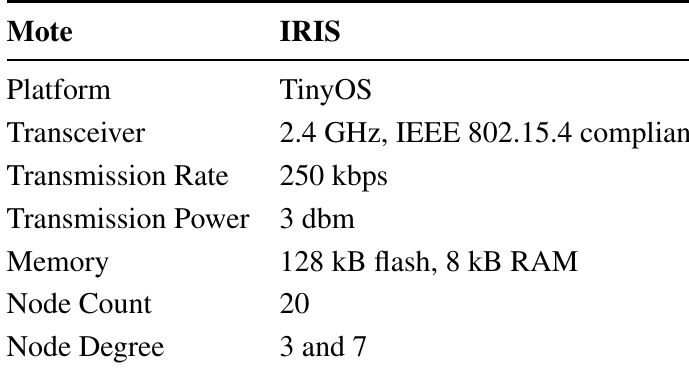
Table 2. Experiment Testbed